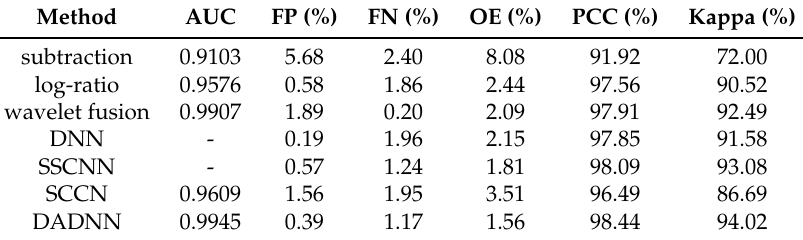
Figure 19. Change detection results obtained by different methods in the Ottawa data set: ( a ) subtraction, ( b ) log-ratio, ( c ) wavelet fusion, ( d ) DNN, ( e ) SSCNN, ( f ) SCCN, ( g ) DADNN, and ( h ) ground truth. Table 3. Value of evaluation criteria of the Ottawa data